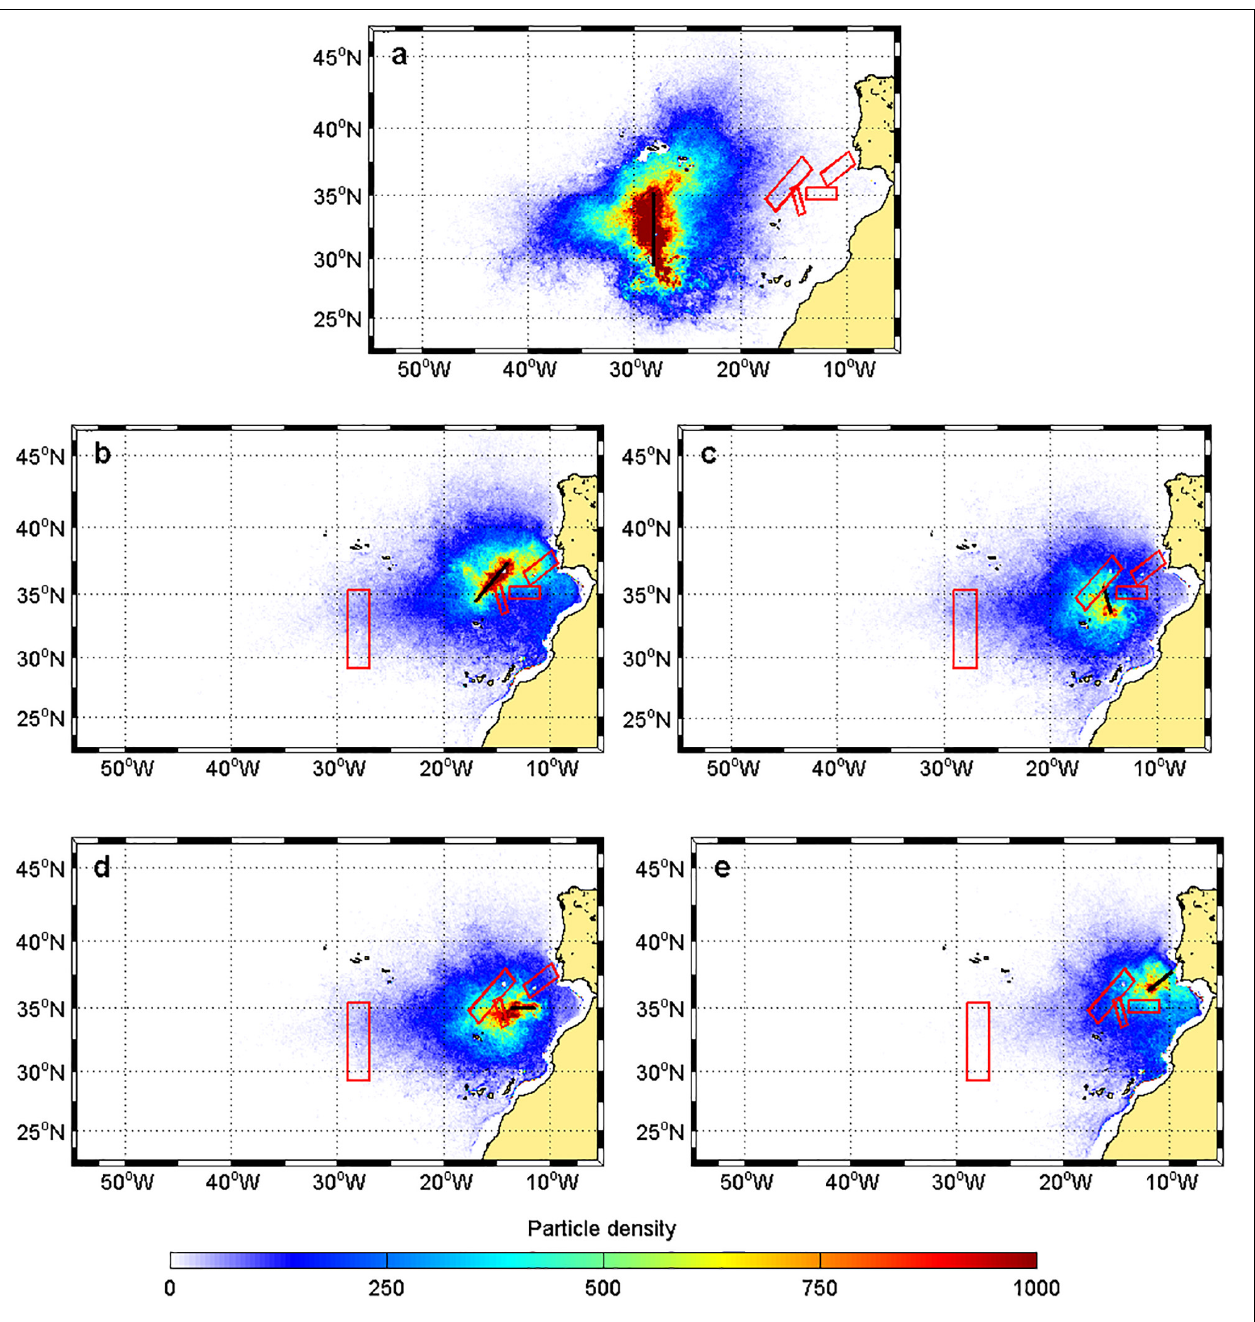
FIGURE 4 | Particle density distribution for the reverse particle tracking study at 1,000 m depth for particles released at the different seamounts: (a) Great Meteor, (b) Lion-Josephine, (c) Unicorn-Seine, (d) Ampere-Coral, and (e) Gorringe Bank. The black bar corresponds to the final destination of the particles. The red boxes represent the nearby seamounts of interest (as identified in Figure 1b